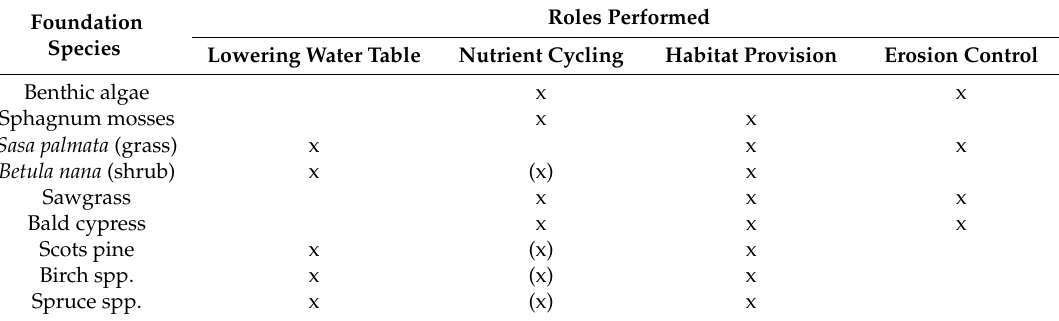
Table 1. Foundation species analyzed and their respective roles in controlling ecosystem functions in freshwater wetlands. Direct roles are indicated by ‘x’, while indirect ones are indicated by ‘(x)’—for example, some foundation species lower the water table, which increases the rate of aerobic decomposition, in turn accelerating nutrient cycling and thus increasing nutrient